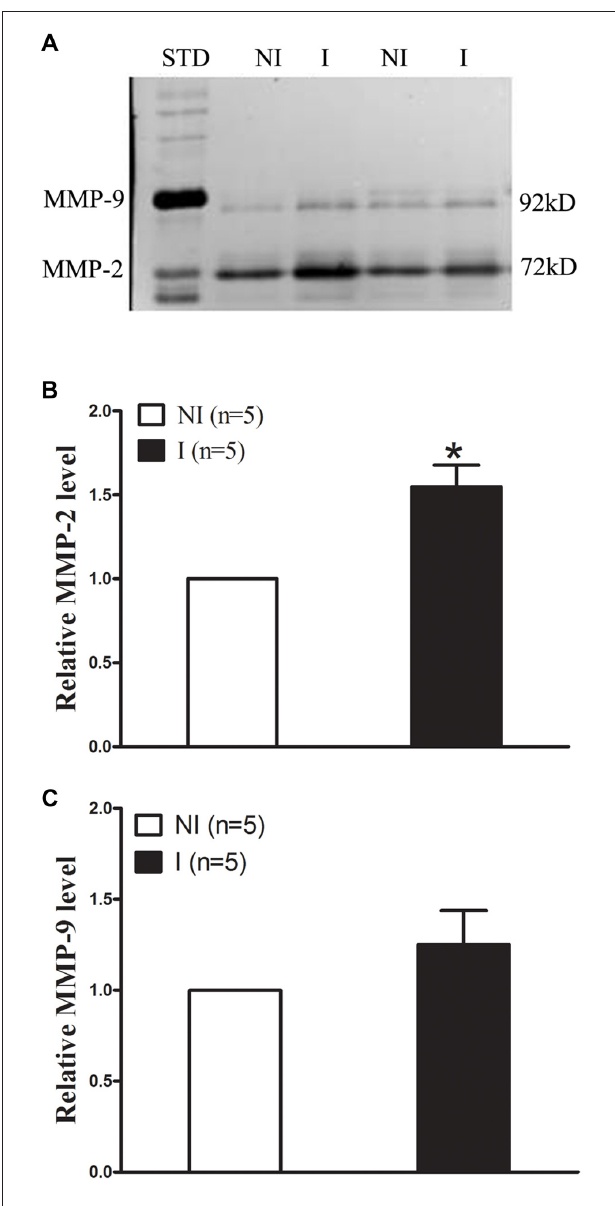
FIGURE 2 | Effect of 2-h ischemia on MMP-2/9 induction. MMP-2/9 was induced in ischemic brain tissue after 2-h ischemia. (A) Representative gelatin zymogram showed MMP-2/9 levels in the non-ischemic (NI) and ischemic (I) hemispheric tissue. MMP-2 bands were much stronger than MMP-9 bands on zymogram gels. STD is a mixture of standard MMP-2/9. The relative band intensity of MMP-2 (B) and MMP-9 (C) was quantified. A significant increase was observed for MMP-2 in the ischemic tissue after 2-h middle cerebral artery occlusion (MCAO; ∗ P < 0.05 vs. NI, n = 5), while there was no significant increase for MMP-9 ( P > 0.05 vs. NI, n = 5). Data were expressed as mean ±